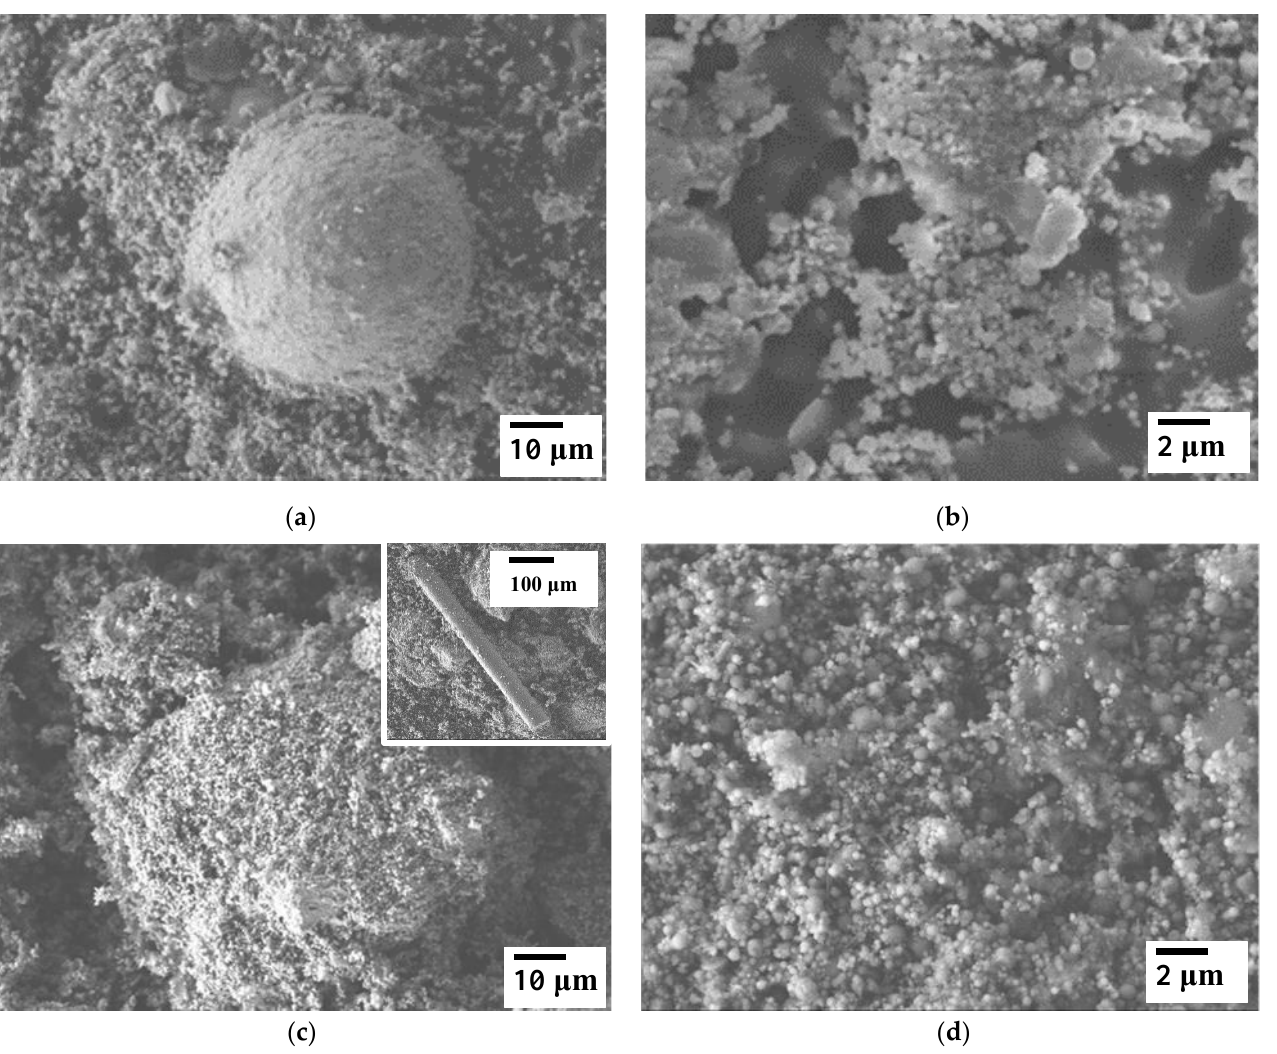
Zn, or Mn) [9,15,40].